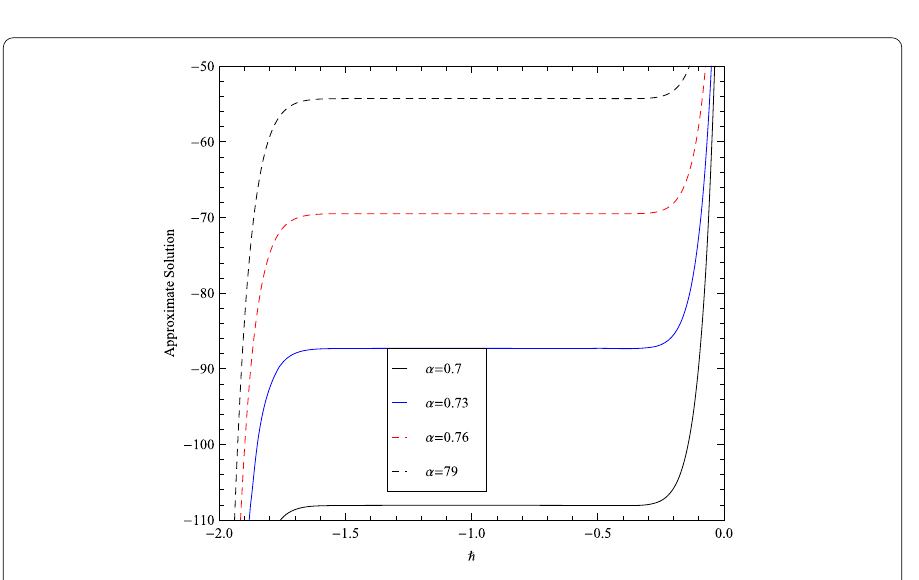
Figure 8 Plot of (cid:2) curve for different values of λ at x = 0.5 and t =